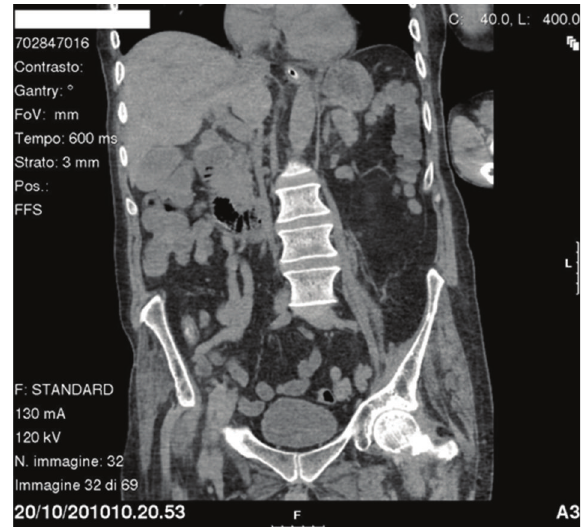
Figure 1: Upper oral contrast series showing contrast stop point in duodenum.